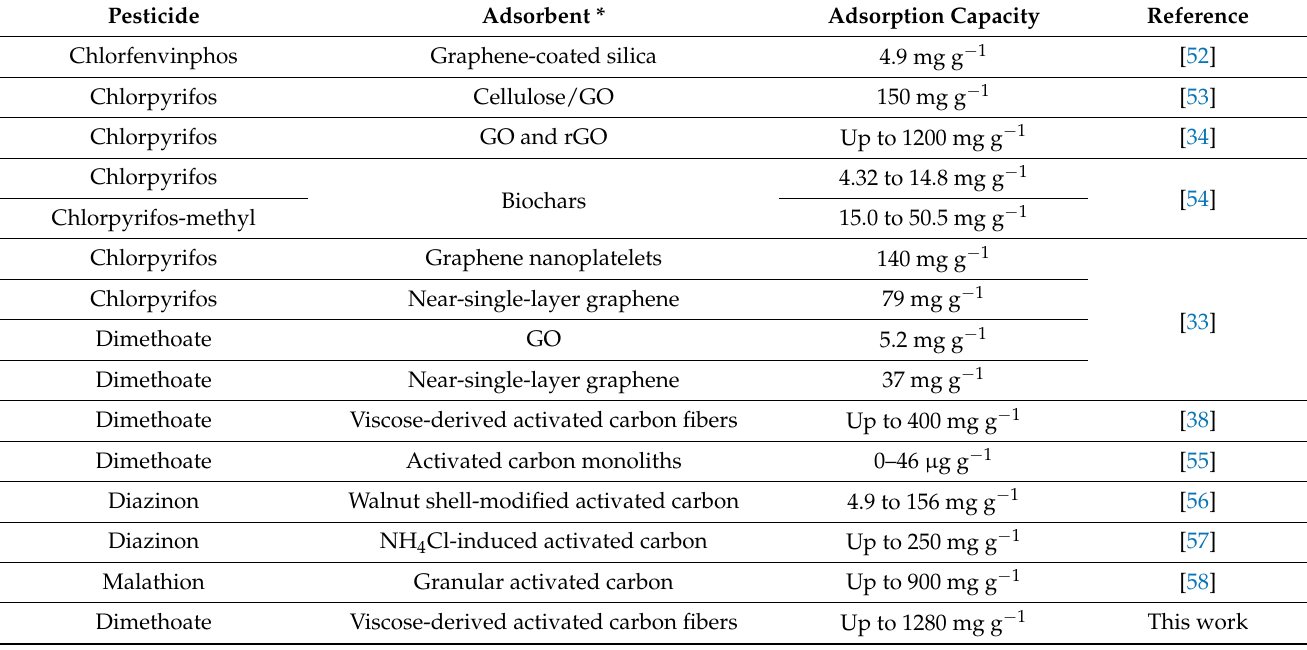
Table 6. Comparison of literature data regarding adsorption capacities of organophosphate